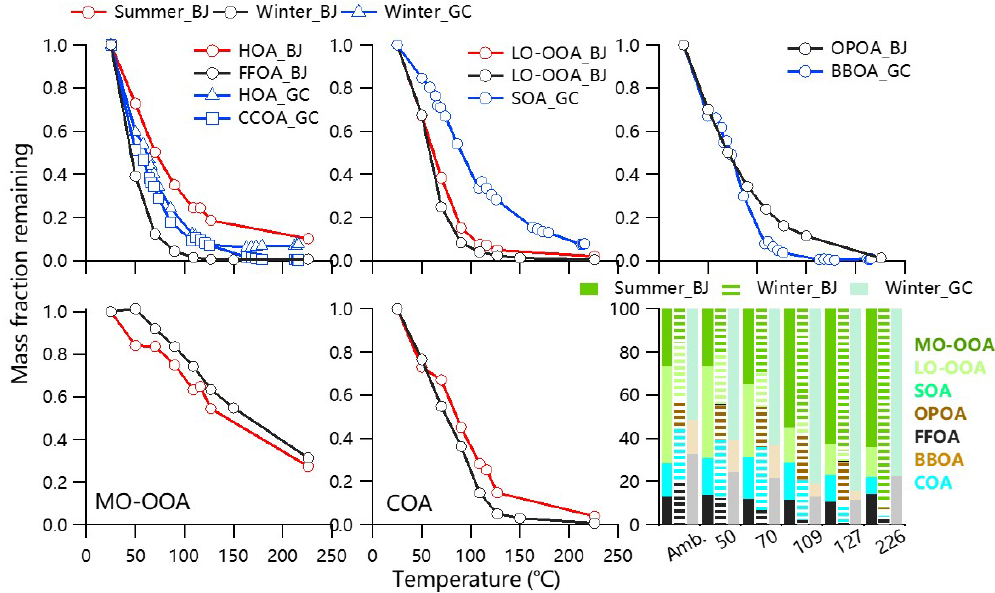
Figure 2. Thermograms of OA factors at both urban and rural sites. The mass fractions of OA factors as a function of TD temperature are also